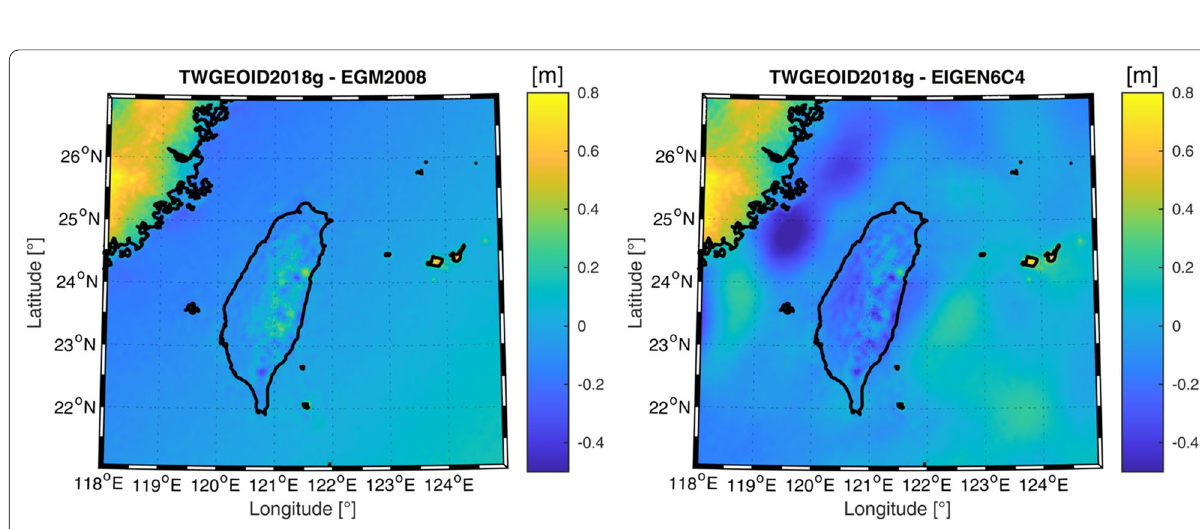
Fig. 4 Residuals of the comparison of the TWGEOID2018 geoid model (gravimetric version) with respect to EGM2008 and EIGEN6C4 global models (over the Taiwan area). The results of the same comparison computed with the hybrid version of the TWGEOID2018 geoid model are not reported, because they show an almost identical